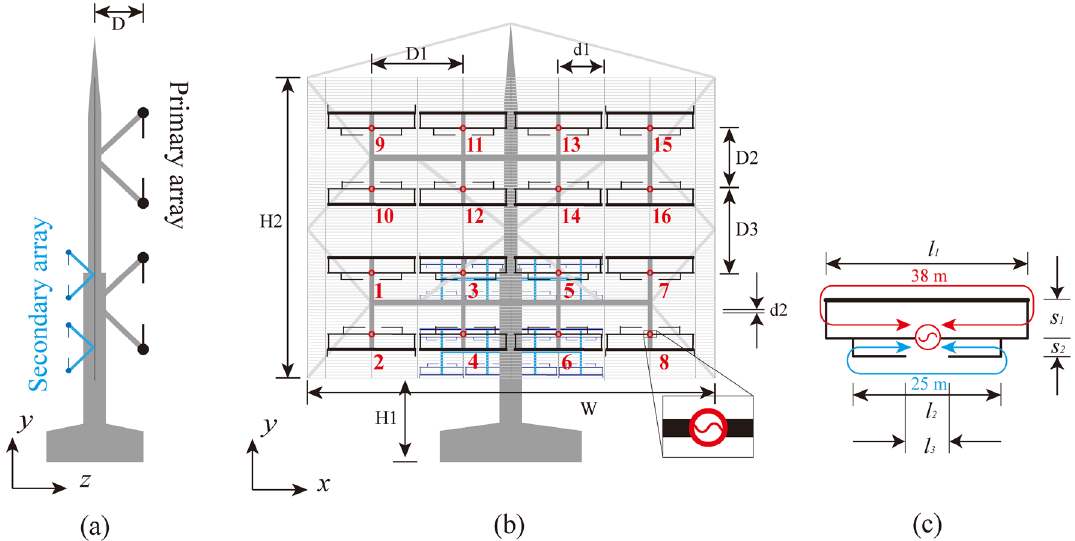
Figure 2. Antenna for SW broadcasting: ( a ) side view, ( b ) front view, ( c ) modified folded dipole. D = 9 m, D1 = 18 m, D2 = 15 m, D3 = 19 m, d1 = 9 m, d2 = 0.7 m, H1 = 15 m, H2 = 63 m, W = 75 m, l 1 = 17 m, l 2 = 11.5 m, l 3 = 4 m, S 1 = 2 m, and S 2 = 1